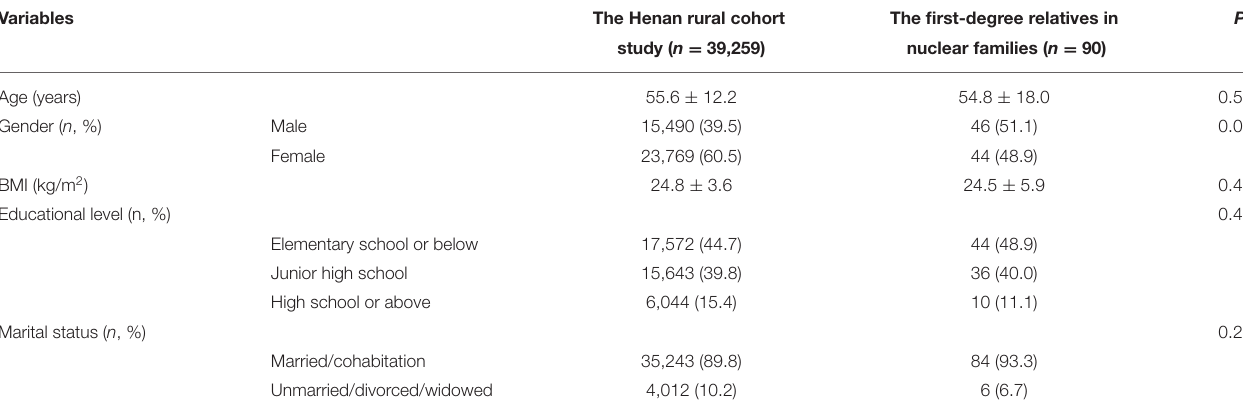
TABLE 1 | Characteristics of The Henan Rural Cohort Study and family-based study